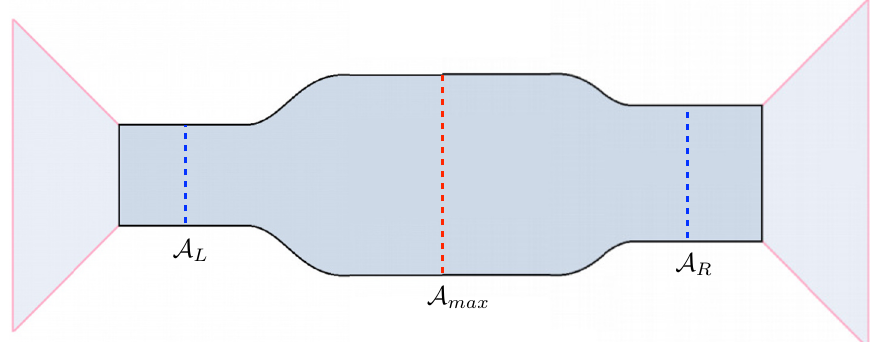
Figure 1 . A spatial slice through a ‘Python’s Lunch’ geometry. On the far left, the wormhole opens up to one asymptotic region with in(cid:12)nite cross-sectional area; on the far right, the wormhole opens up to the other asymptotic region also with in(cid:12)nite cross-sectional area. In AdS-Schwarzschild black holes the cross-sectional area reaches a minimum in the middle of the wormhole, and increases on either side. By contrast, in the Python’s Lunch geometry the cross-sectional area (cid:12)rst shrinks, then grows, then shrinks, then grows again, giving rise to a bulge in the middle of the wormhole | the eponymous Lunch. and are the areas of the minimal surfaces on each side and A L A R area of the luncheon